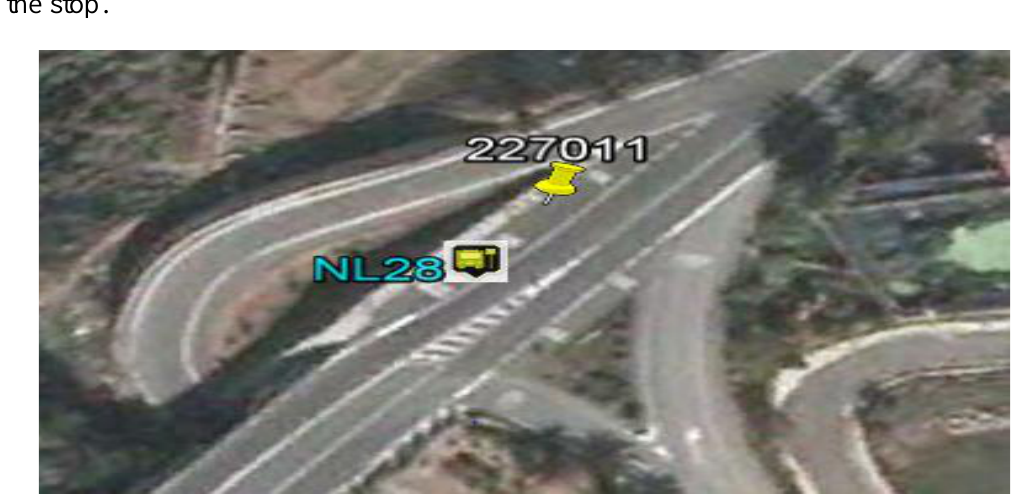
Figure 3. Aerial view of a cluster of type G1. Tag NL28 represents the centroid of the group of readings obtained when the vehicle stopped. Tag 227011 represents the position of the